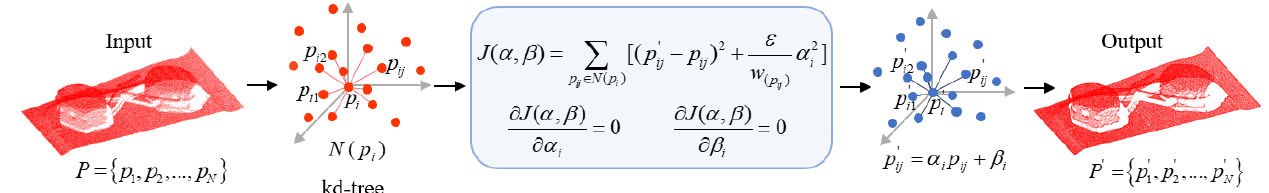
Figure 3. The pipeline of the AWGF.